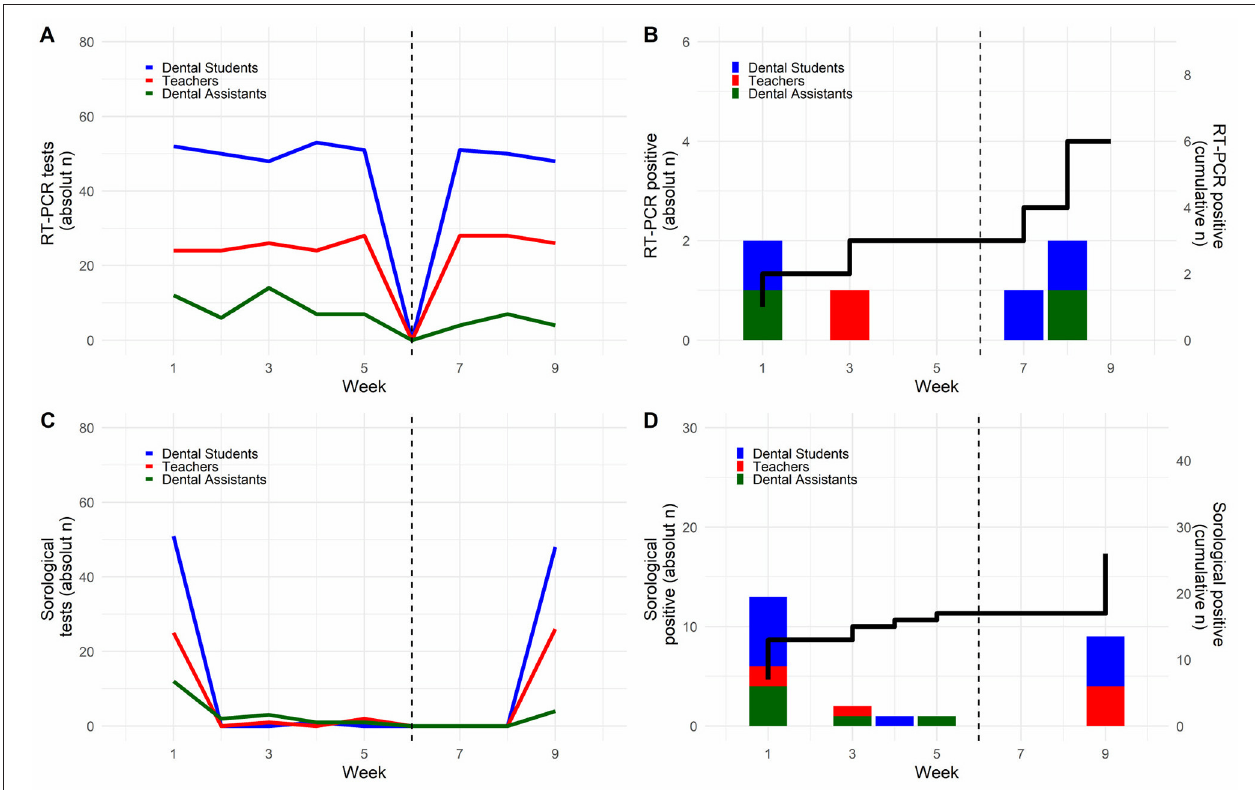
FIGURE 2 | RT-PCR and serological tests in dental healthcare professionals. (A,B) Shows the number of RT-PCR tests and positive results, respectively. The black line shows cumulative cases (C,D) present the number of serological tests and the positive results of each week of the study. The black line shows cumulative cases.